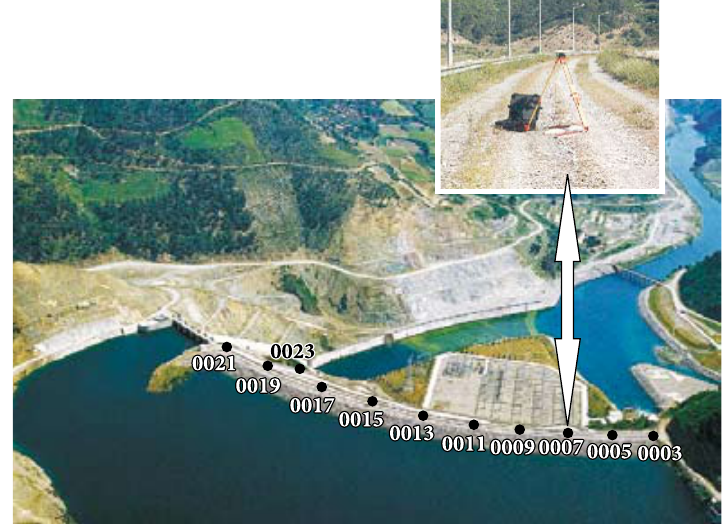
Fig. 3. Object network of Altýnkaya